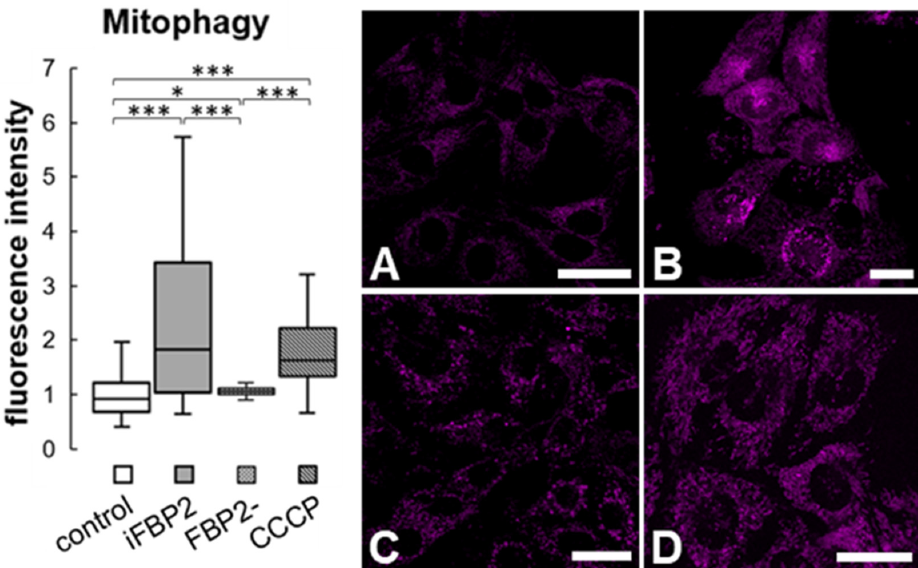
Figure 4. Mitophagy in HL-1 cells. Quantification of fluorescence intensity related to mitophagy and representative images of cells stained using Mitophagy Detection Kit. The fluorescence was normalized to control group. Control—untreated HL-1 WT cells ( A ), iFBP2—FBP2 tetramerizing agent-treated cells ( B ); FBP2—-cells with partially silenced expression of FBP2 ( C ), CCCP—HL-1 WT cells incubated with CCCP, a mitophagy inducing agent ( D ). Data are presented as median and interquartile range. * p < 0.05 *** p < 0.001. Bar = 20 µm.